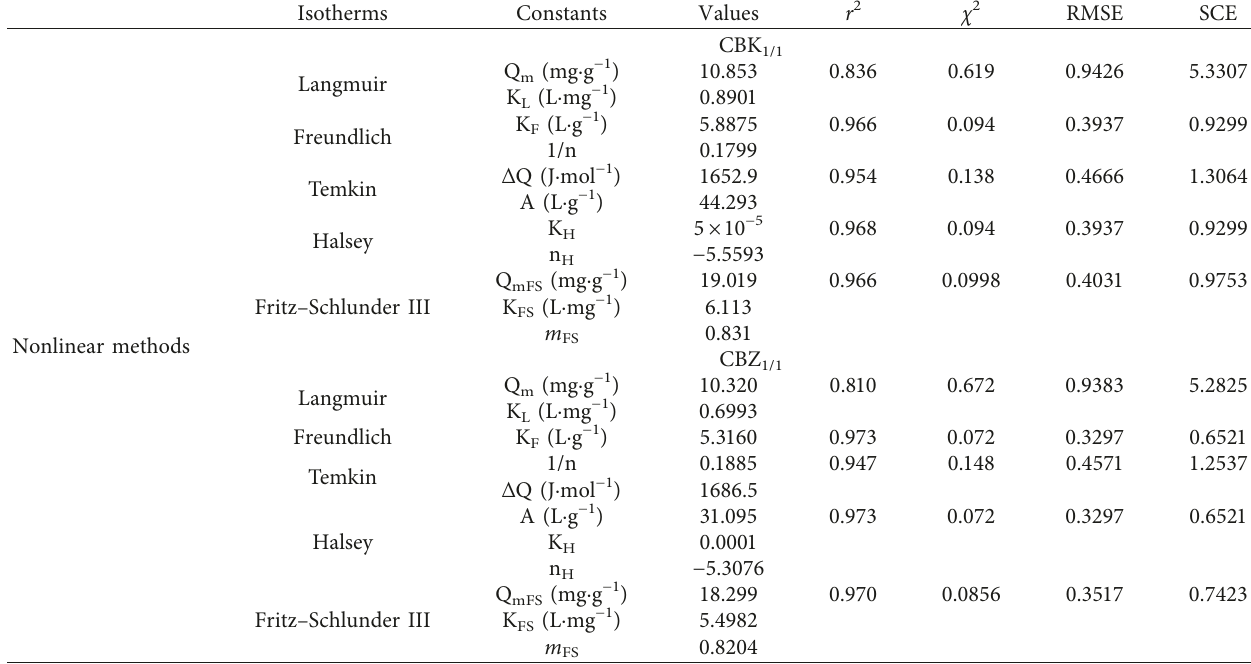
Table 7: Nonlinear parameters of isotherm models for adsorption of IC onto ACs.